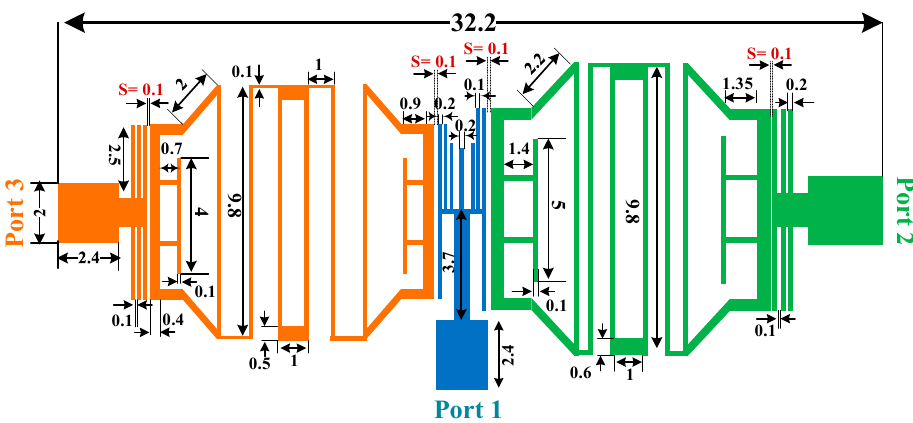
Figure 11. Proposed diplexer layout with dimensions (all in mm).